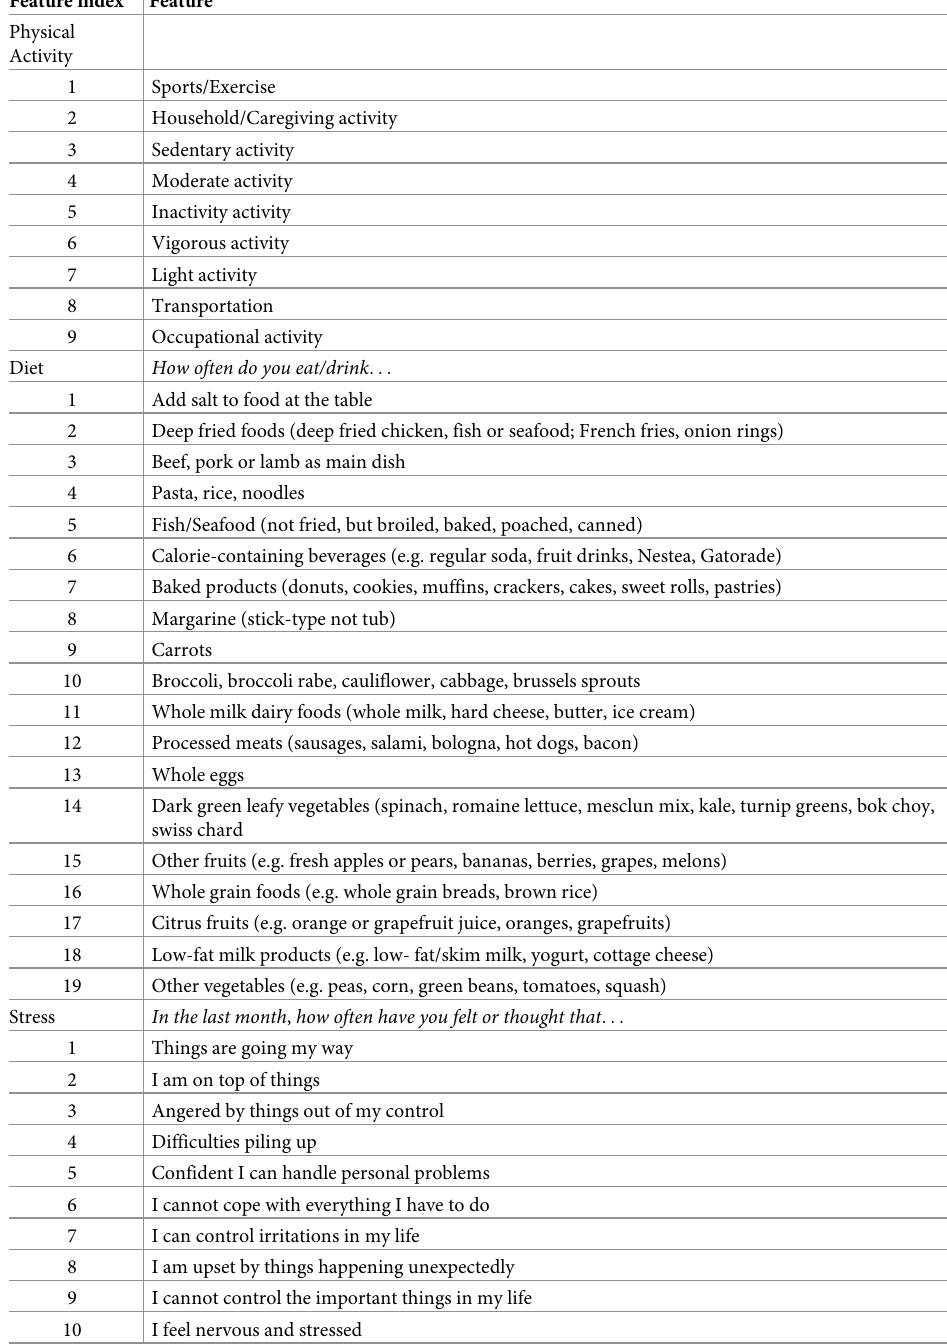
Table 6. Feature corresponding to feature index in Fig